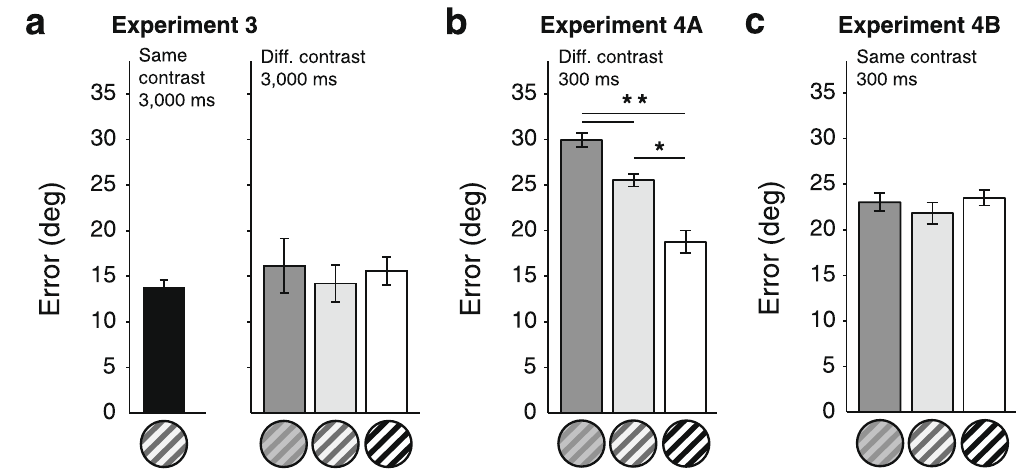
Figure 4. Results of Experiments 3 and 4. ( a ) Results of the working memory task of Experiment 3 averaged over all participants ( n = 9). With a sample duration of 3,000 ms and either the same medium contrast or different contrasts for the three targets, there was no effect of salience on the precision with which target orientations were reproduced from memory. ( b ) Results of the working memory task of Experiment 4A averaged over all participants ( n = 8). With a sample duration of 300 ms and different contrasts for the three targets, there was a significant effect of salience on the precision with which target orientations were reproduced from memory. ( c ) Results of the working memory task of Experiment 4B averaged over all participants ( n = 8). With a sample duration of 300 ms and the same contrasts for the three targets within a trial but different contrasts between trials, there was again no effect of contrast on the precision with which target orientations were reproduced from memory. Error bars represent within-subjects s.e.m.’s 88 . Asterisks indicate